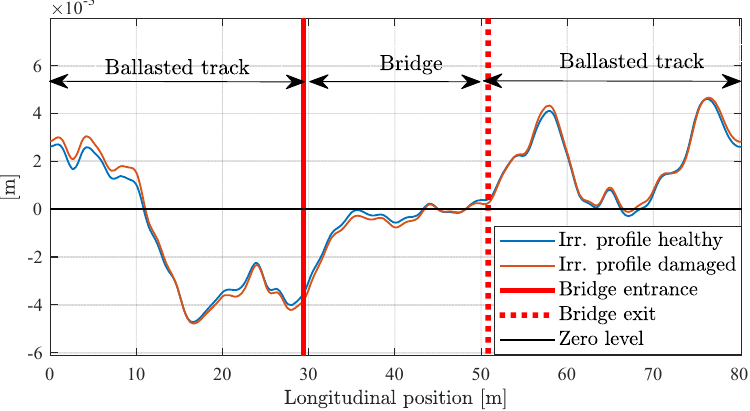
Figure 4. Vertical track irregularity. Example of the differentiation of the vertical profile in the case of a healthy and damaged bridge (instance for the right rail).